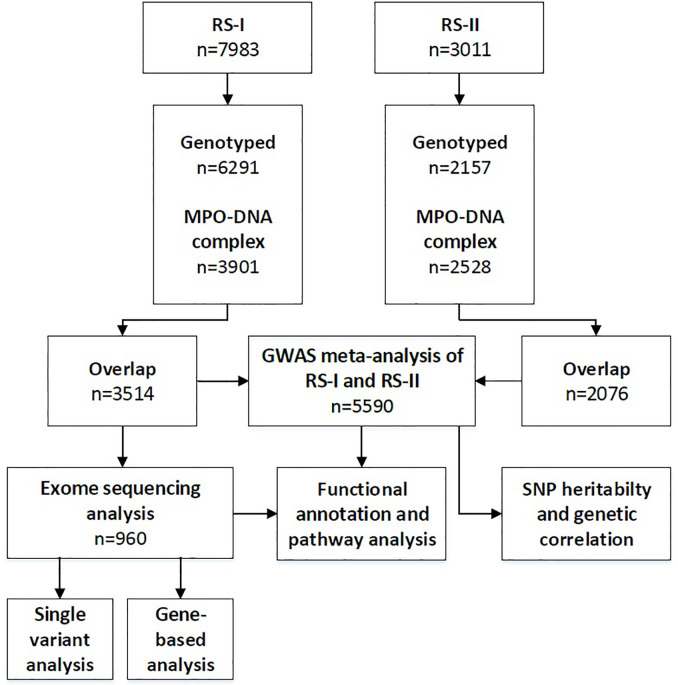
Flow diagram of the number of included individuals and performed analyses. RS-I, Rotterdam Study cohort 1; RS-II, Rotterdam Study cohort 2; GWAS, genome-wide association studies; SNP, single-nucleotide polymorphism.